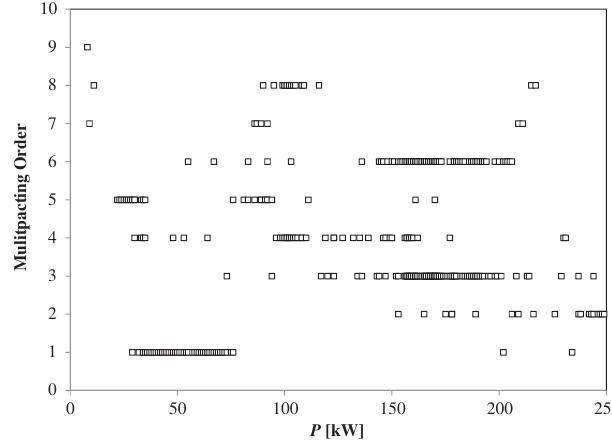
FIG. 14. Multipacting order at different rf power